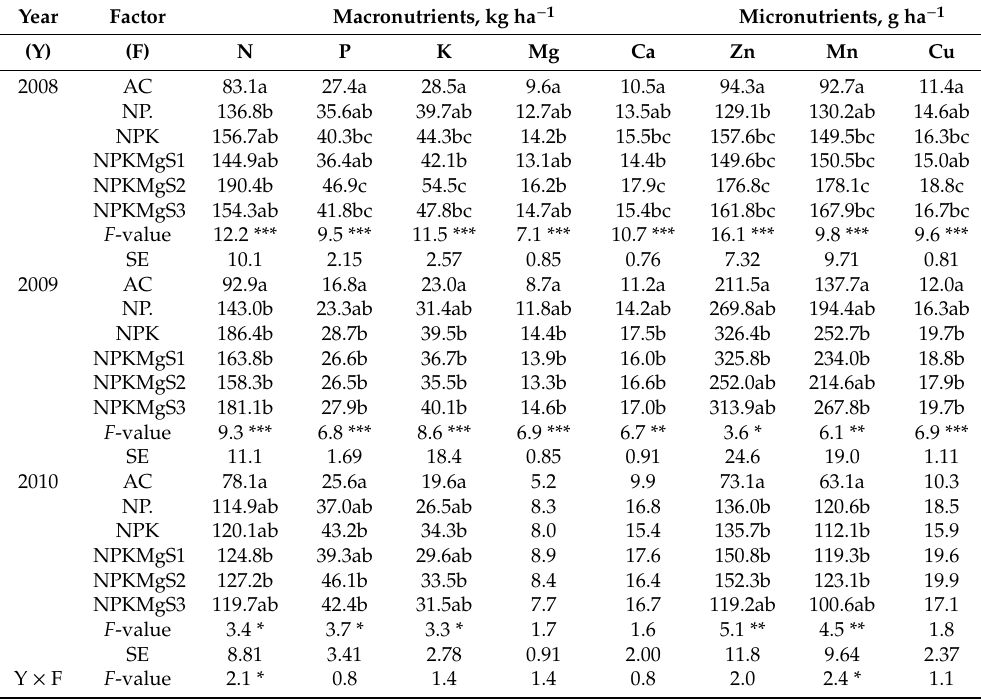
Table 4. Nutrient accumulation in WOSR